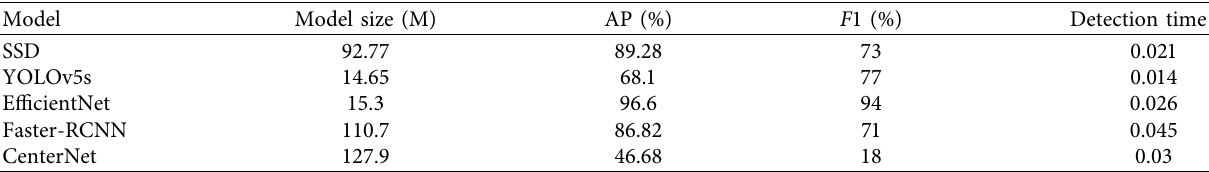
Table 2: Comparison of detection results of fve algorithms.